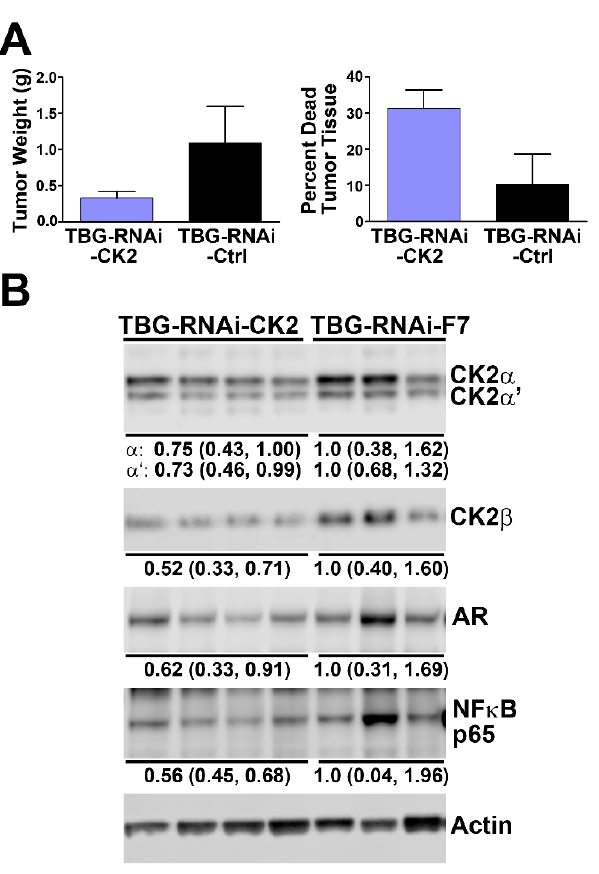
Figure 5. Anti-CK2 nanocapsule RNAi-based systemic treatment reduces expression of CK2, AR and NF κ B p65 in 22Rv1 orthotopic xenograft tumors. ( A ) Orthotopic 22Rv1 tumors were initiated in NOD SCID gamma castrated male mice. When tumors were palpable, mice were treated on days 1, 4 and 7 with TBG-RNAi-CK2 or TBG-RNAi-F7 (control) nanocapsule by tail vein injection (0.02 mg / kg). Tumors were harvested on day 8, 24 h after the last treatment. Tumors were weighed, dissected to remove dead tissue, and reweighed. Mean tumor weights per group are indicated on the left panel and the mean percent of dead tumor tissue removed is indicated on the right panel. TBG-RNAi-CK2, n = 4; TBG-RNAi-F7, n = 3. Error bars indicate standard error. ( B ) Orthotopic xenograft 22Rv1 tumors from mice treated with TBG-RNAi-CK2 or TBG-RNAi-F7 (control) nanocapsule drugs were subjected to immunoblot analysis. Treatments are indicated above the lanes, and proteins detected are indicated to the right of the panels. Mean expression levels and 95% confidence intervals are indicated below the individual blots. Actin was used as a loading control.